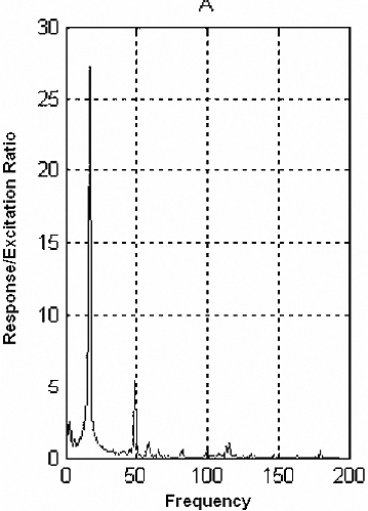
Fig. 1. Typical frequency response function for vibration